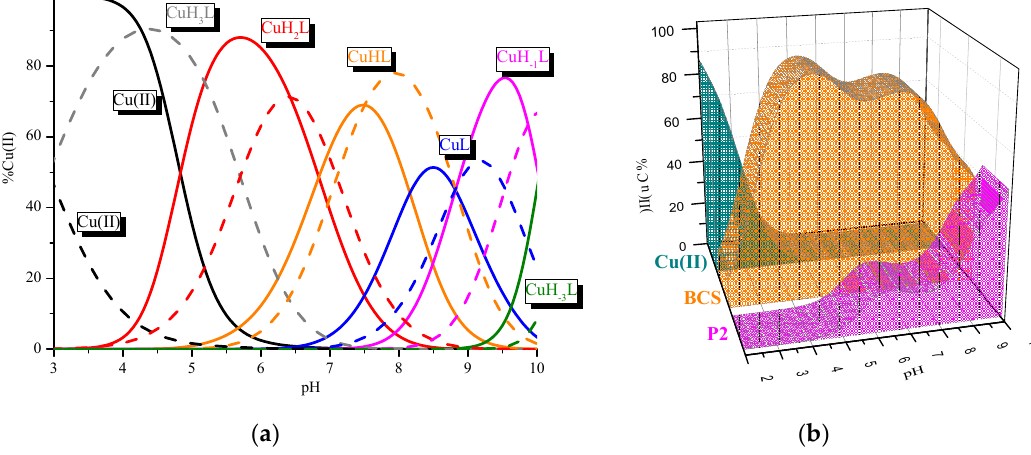
Figure 5. ( a ) Comparison of (a) species distribution curves for Cu(II)/P2 (solid line) and Cu(II)/BCS (dashed line) systems in relation to pH; ( b ) Comparison of the P2/Cu(II)/BCS systems. P2 concentration was 7×10 −4 mol/L and pH-metric titration was performed in a 0.3 mol/L KCl solution using sample volumes of 1.5 mL. Measurements were carried out in a 2.5–10 pH range, at 25 °C. The ligand to metal ratio was 2:1.